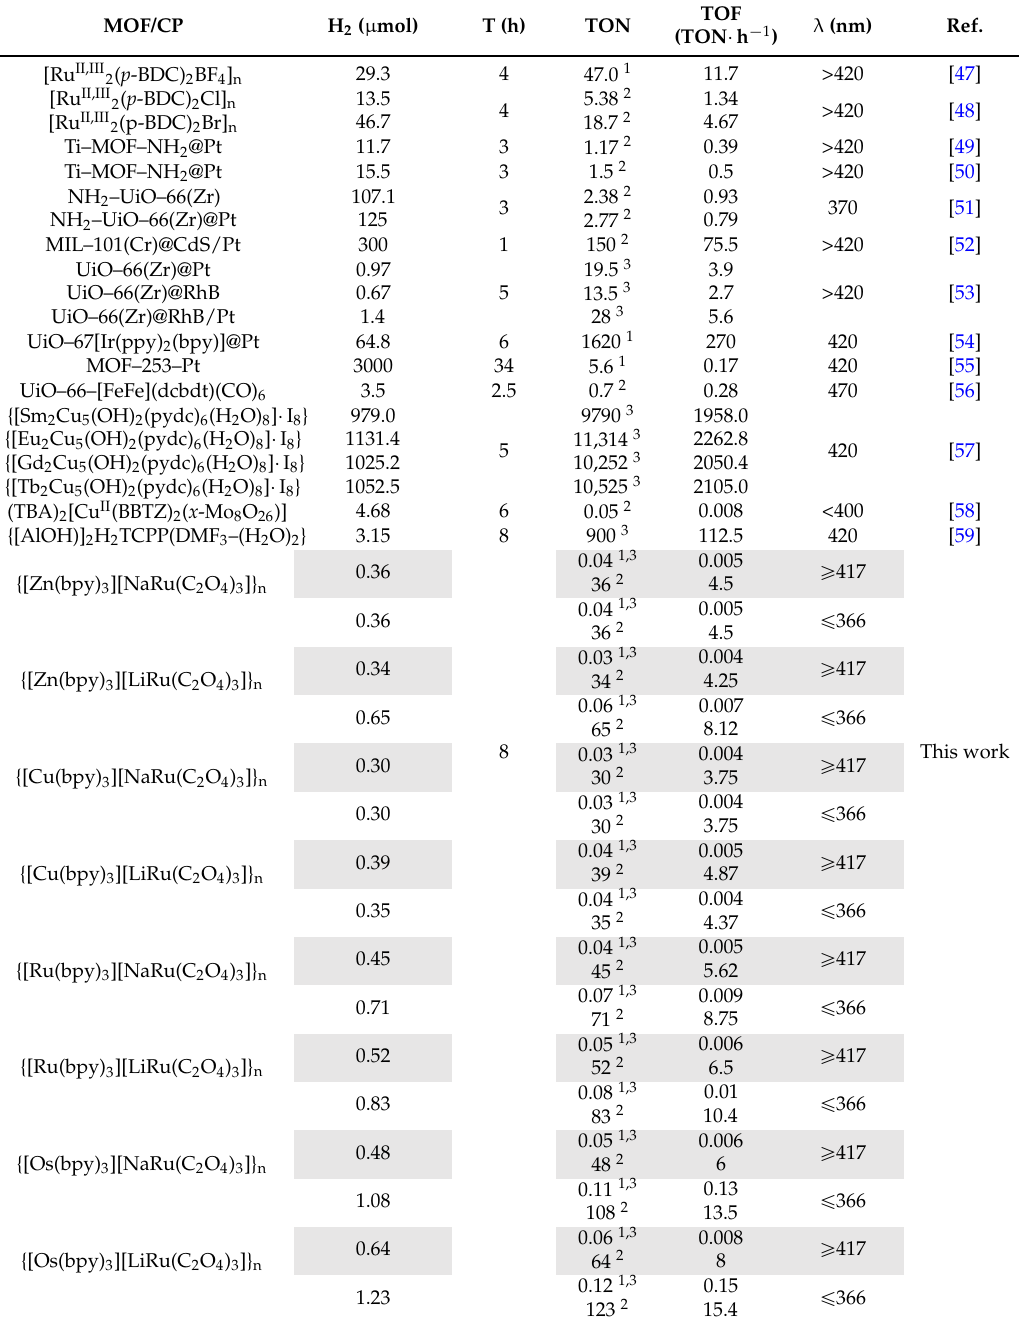
Table 2. Comparison of photocatalytic performances of known MOFs/CPs used in the photoreduction of water to H 2 under UV and Vis